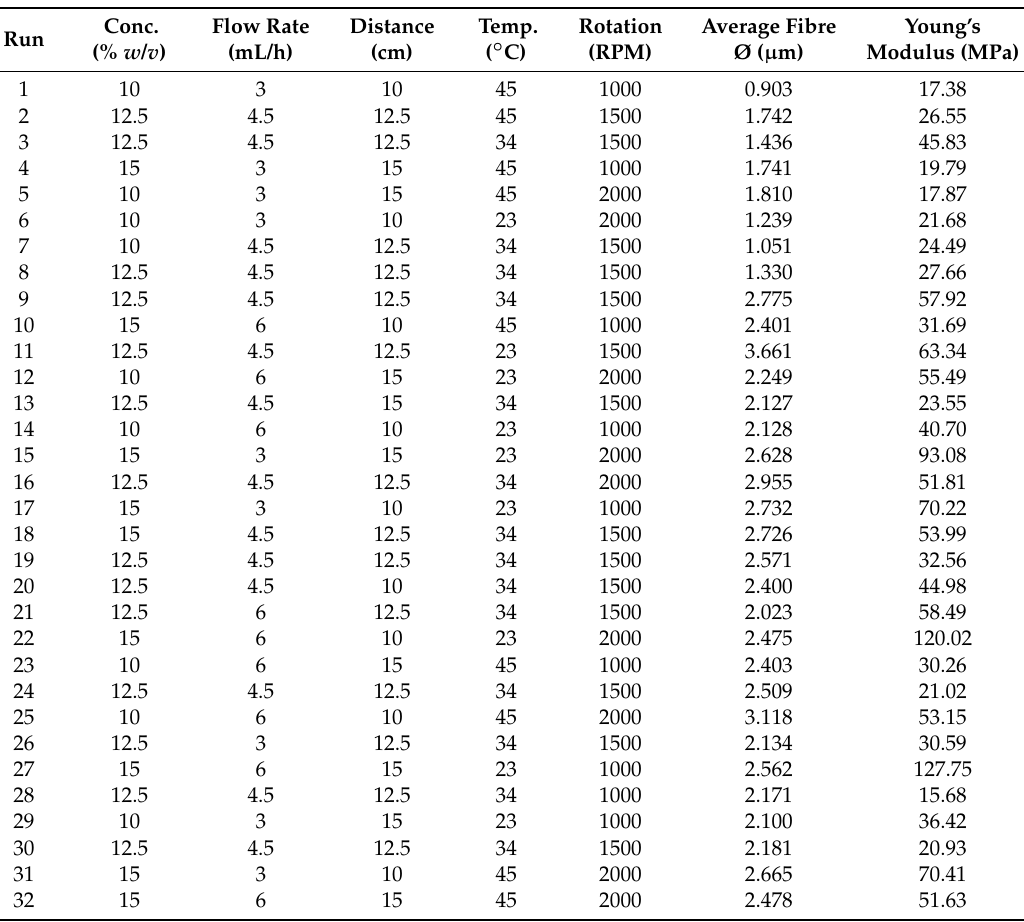
Table 2. Experimental conditions and the response